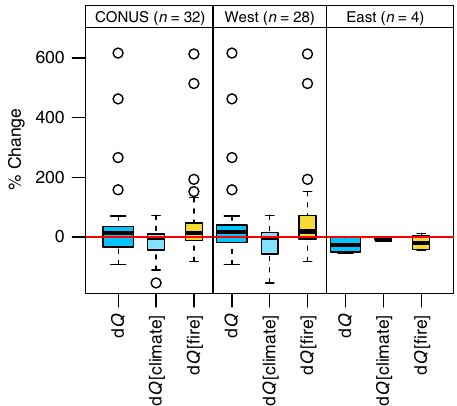
Fig. 3 CONUS-East-west comparison of post- fi re change in annual river fl ow. Percentage change in 5-year mean annual river fl ow observed (d Q ) attributed to climate (d Q [climate]) and fi re (d Q [ fi re]), respectively, for watersheds burned between 1985 and 2008 (BAR ≥ 19%). Results are summarized for the CONUS ( n = 32) and for the regions west ( n = 28) and east ( n = 4) of the Mississippi River, respectively. Whiskers extend to the most extreme value no more than 1.5× interquartile range from the box